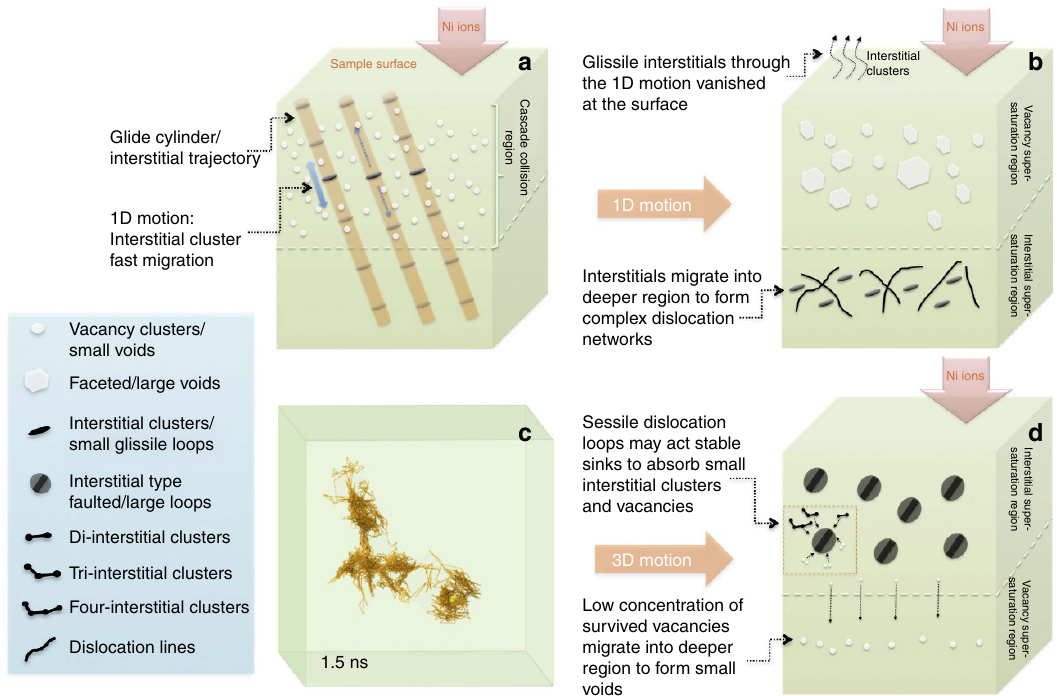
Figure 3 | 1D and 3D motions of interstitial clusters under ion irradiation. ( a ) Schematic illustration of 1D motion in nickel and NiCo. Interstitial clusters migrated fast along the glide cylinder. ( b ) Schematic sketch of defect evolution and distribution in nickel and NiCo as a result of a . ( c ) MD simulation result of the trajectory of the centre of a four-interstitial cluster in NiFe showing a 3D migration mode. ( d ) Schematic sketch of defect evolution and distribution in NiFe, NiCoFe, NiCoFeCr and NiCoFeCrMn as a result of c .